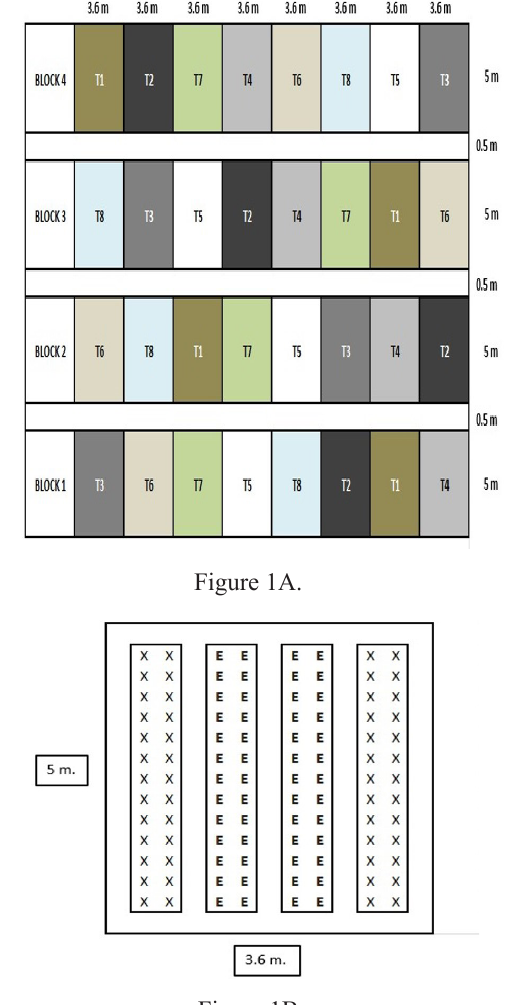
Figure 1A Layout of plots in the experimental area; Figure 1B. Distribution of assessed plants (E) and no-assessed plants (X) in the